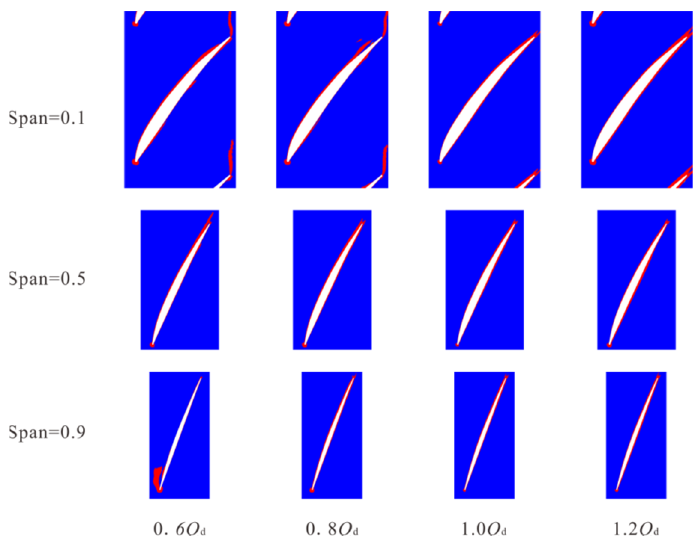
Figure 8. The distribution of sheer strain rate exceeding the threshold in impeller at different flow rates.(The red area is above the sheer strain rate threshold and The blue area is below the sheer strain rate threshold.)